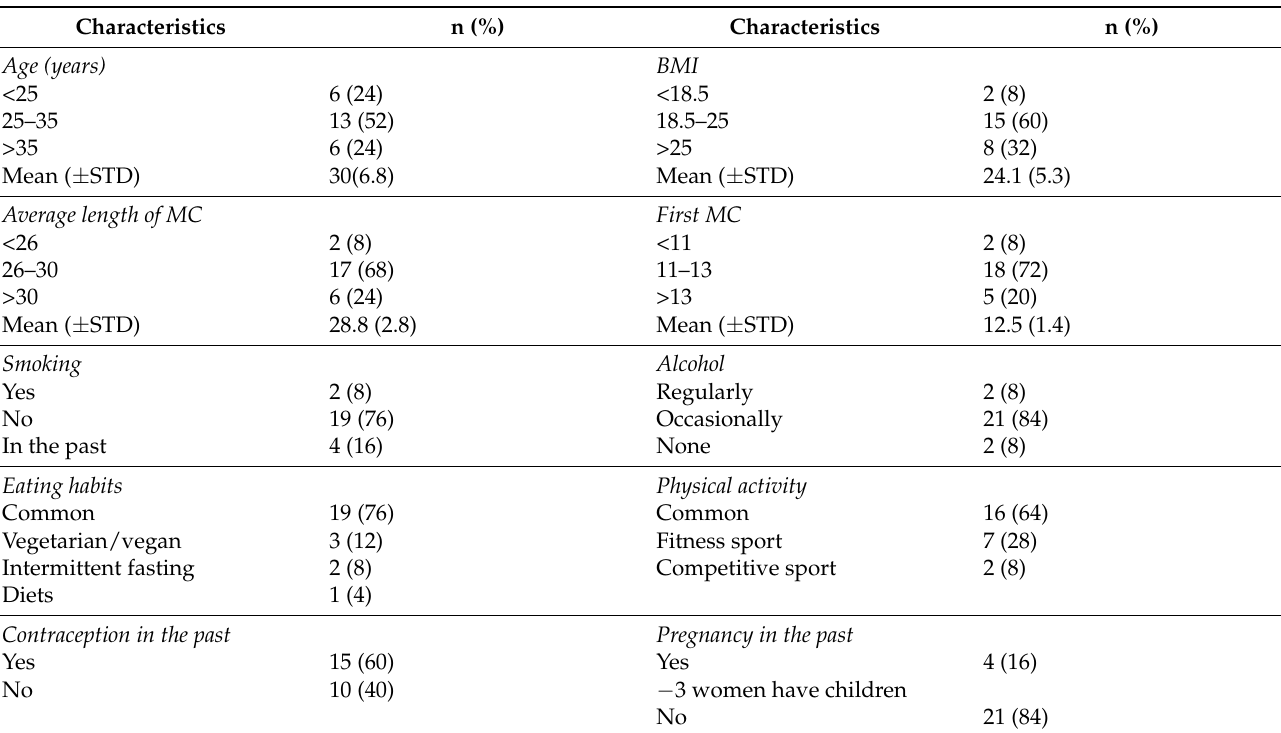
Table 3. Characteristics of the study group ( n = 25). MC—menstruation